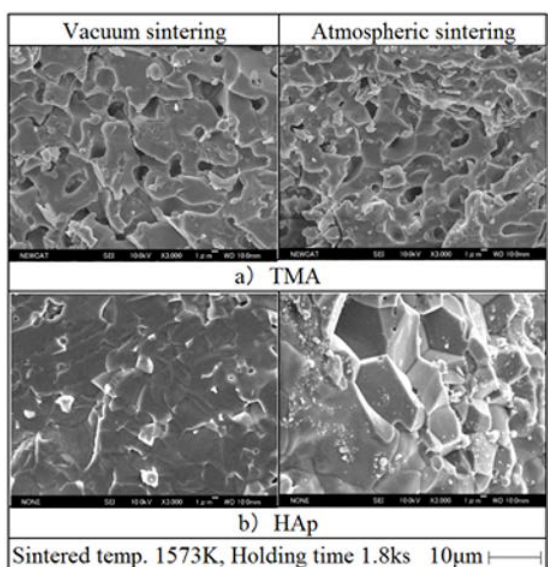
Figure 1. SEM photographs of the fracture surfaces of sintered bod- ies of TMA and HAp fractured in compression tests.